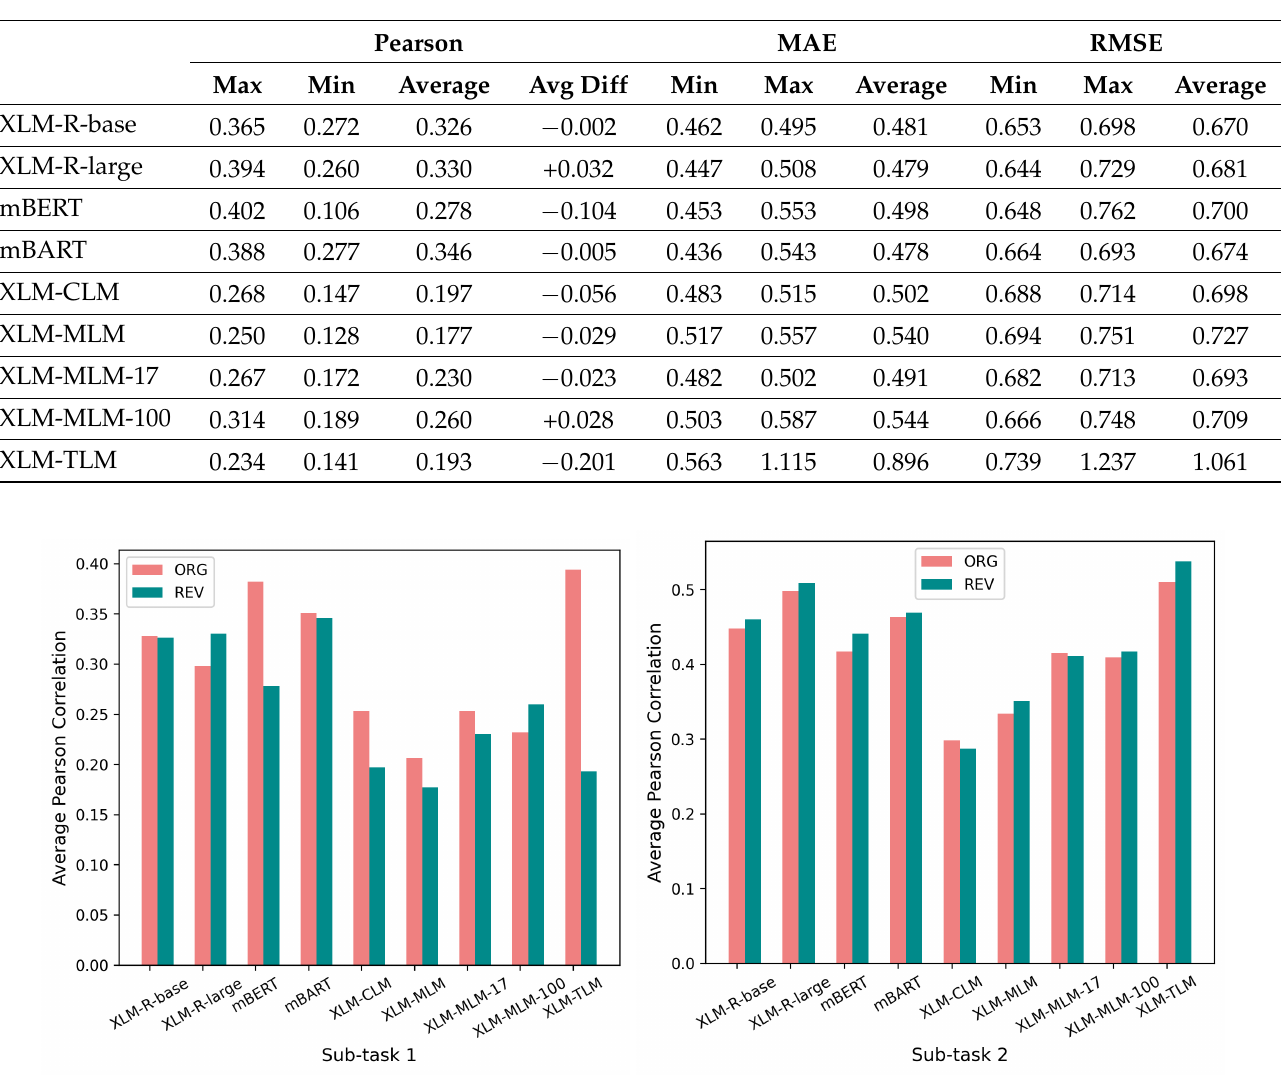
Figure 1. Comparison of the average Pearson correlation coefficients of original and reverse order inputs in sub-tasks 1 and